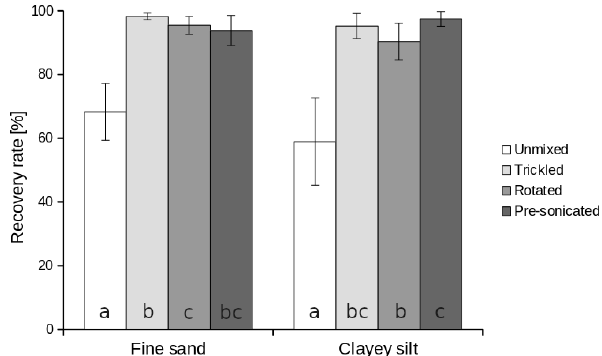
Figure 2. Recovery rates of fPOM (weathered LD-PE) from min- eral matrices after fractionation with 1.6gcm − 3 dense SPT solution using different approaches ( n = 6; t test; p < 0 . 05). Small letters indicate Tukey’s characters. Error bars refer to standard